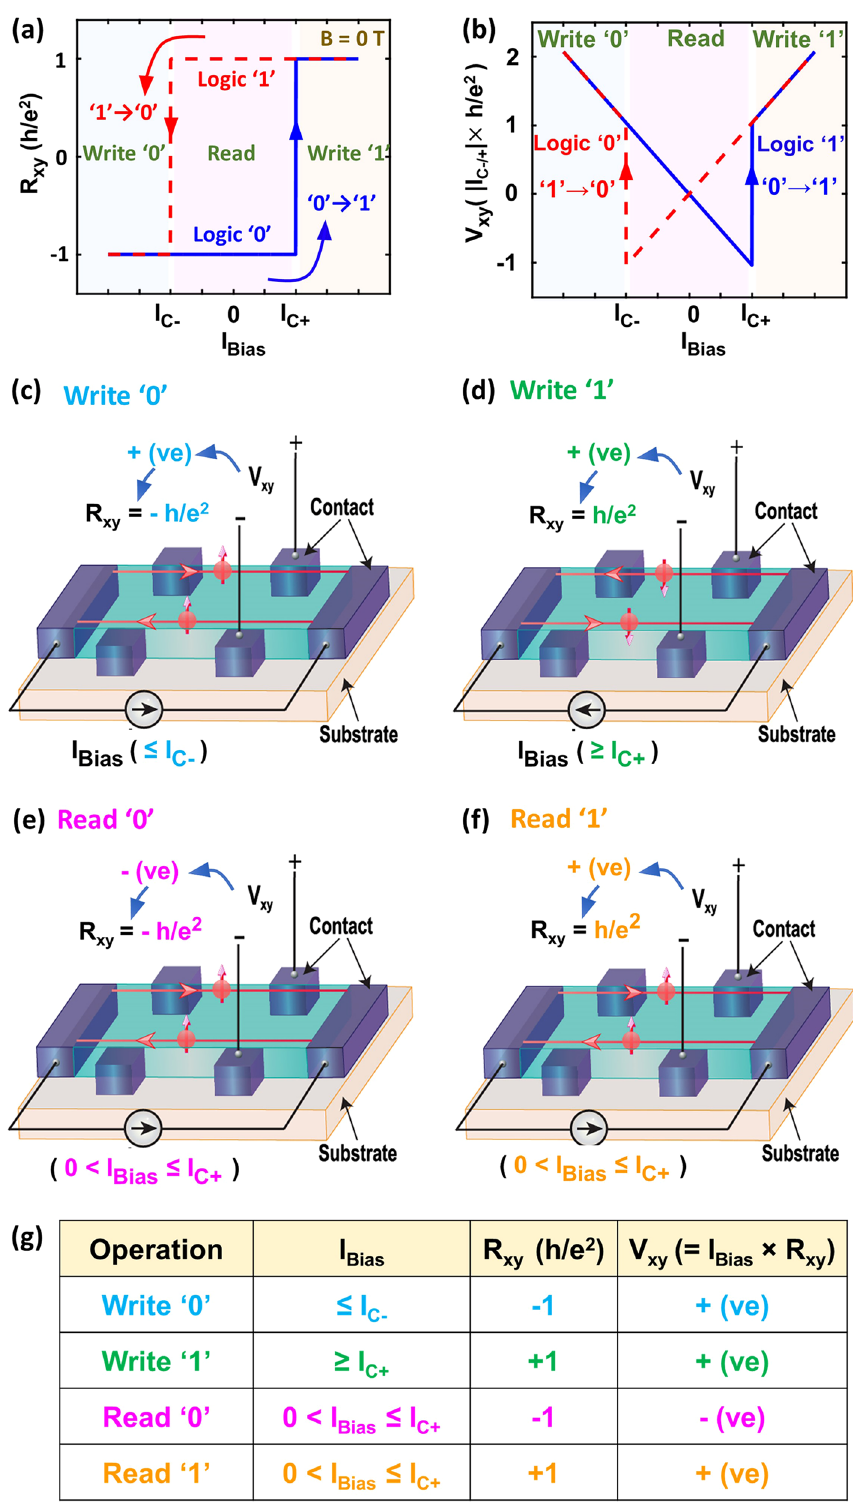
Figure 2. Illustration of the quantum anomalous Hall effect based memory operation. ( a ) R xy vs. I Bias at zero external magnetic field. Hall resistance values of − h/e 2 and + h/ e 2 are defined as logic ‘0’ and logic ‘1’ respectively. Three regions: (i) I Bias ≤ I C- , (ii) I Bias ≥ I C + , and (iii) I C− < I Bias < I C + are marked as write ‘0’, write ‘1’ and read region, respectively. We use this division to choose the required I Bias for different memory operations. ( b ) Hall voltage, V xy plotted as a function of I Bias . ( c ), ( d ), ( e ), & ( f ) The procedures of write ‘0’, write ‘1’, read ‘0’, and read ‘1’ operations, respectively, along with the state of electron spins (red arrows). ( g ) Summary of the key idea for the QAHE based memory. The table enlists the required ranges of I Bias corresponding to all memory operations, along with the corresponding Hall resistance and Hall voltage